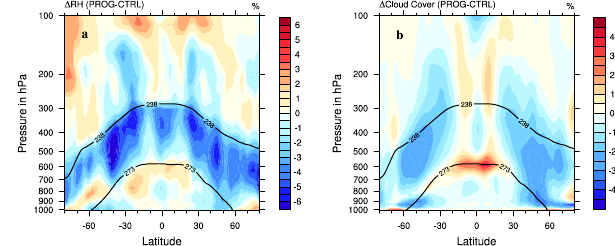
Figure 5. Annual mean difference in (a) RH and (b) TCC of PROG-CTRL, respectively. The solid black lines in (a) represent the melting and the homogeneous freezing levels at T = 273 and T = 238K,